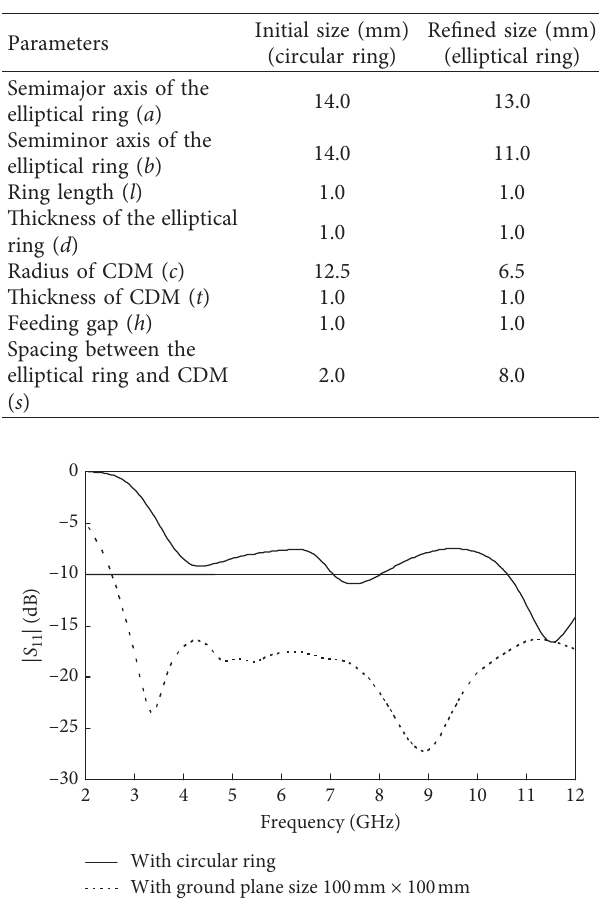
Figure 2: Simulated | S 11 | of CDM with the circular ring and with the ground